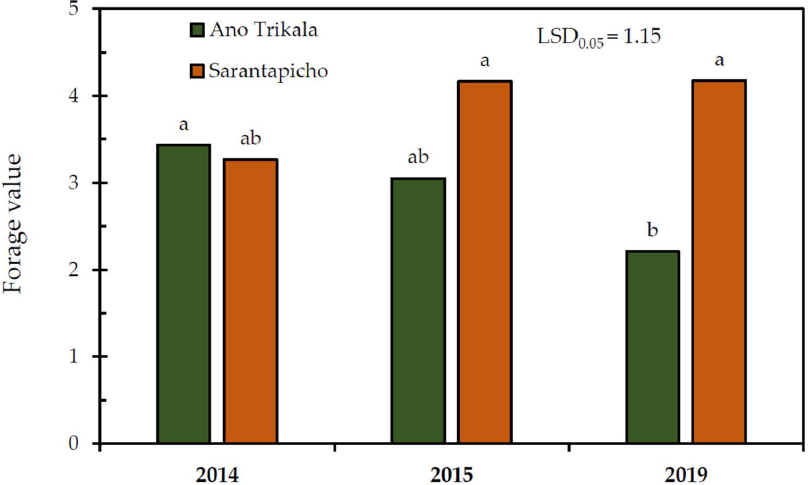
Figure 3. Effects of site and year on landscape function index. Columns followed by the same letter are not significantly different ( p > 0.05).